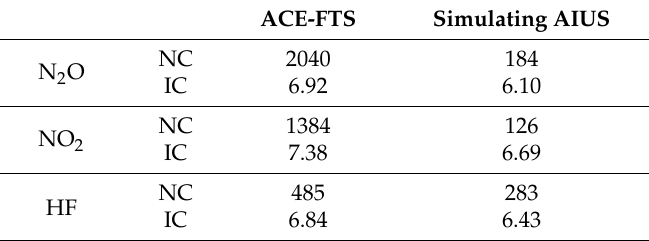
Table 1. Comparisons of number of channels and information content between the Atmospheric Chemistry Experiment–Fourier Transform Spectrometer (ACE-FTS) and simulating the Atmospheric Infrared Ultraspectral Sounder